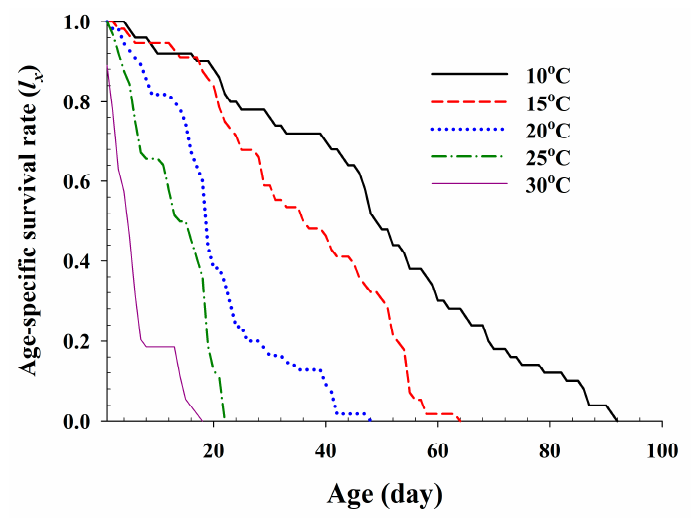
Figure 2. The age-specific survival rate ( l x ) of Acyrthosiphon pisum in response to different temperature conditions.